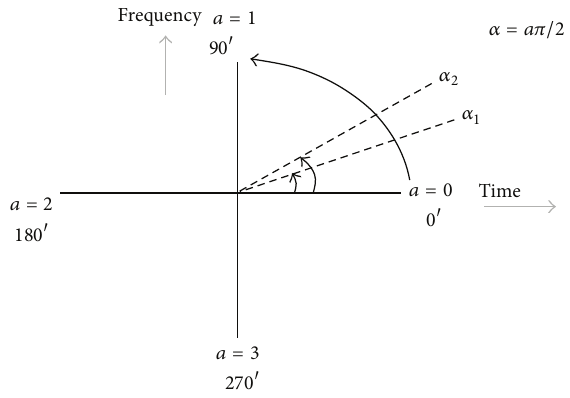
Figure 1: FRFT in time-frequency